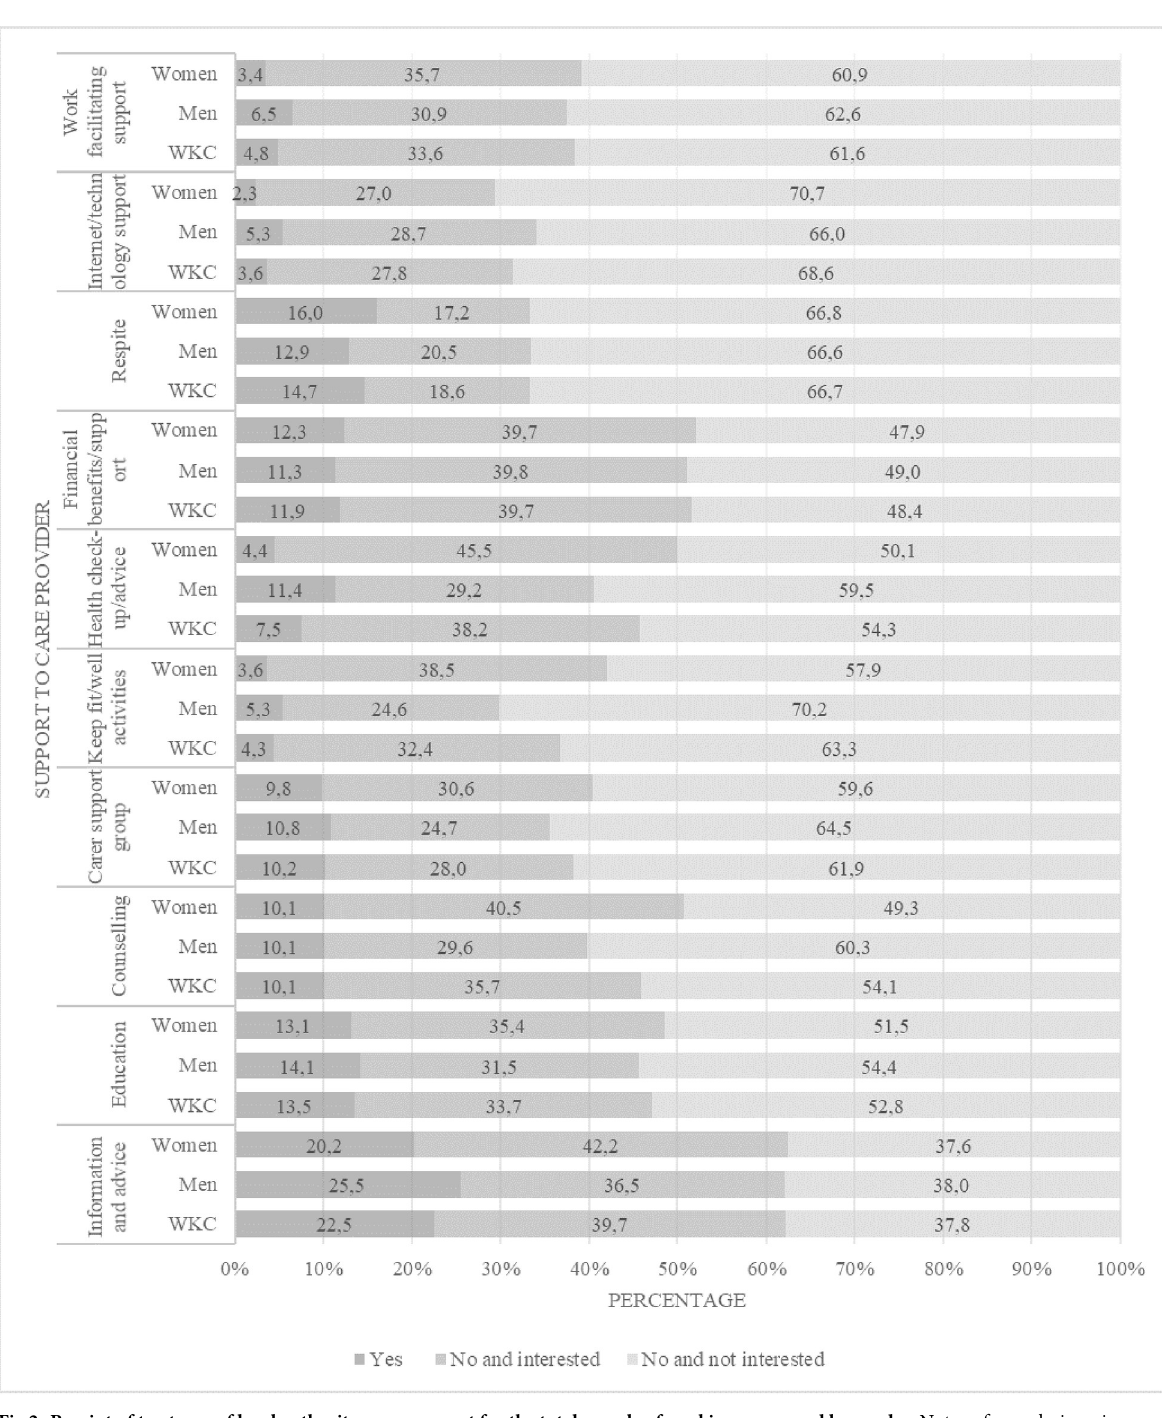
Fig 2. Receipt of ten types of local authority carer support for the total sample of working carers and by gender. Note: n for analysis varies between n = 789 and n = 769 due to internal missing data. least 50% (see Table 3). Female compared with male WKCs disproportionately reduced their hours by 50% (women, 21.3%; men,5.5%), with male compared with female WKCs more likely to reduce their hours by greater than 50% or less than 50% ( χ 2(2) = 6.99, p = .030).